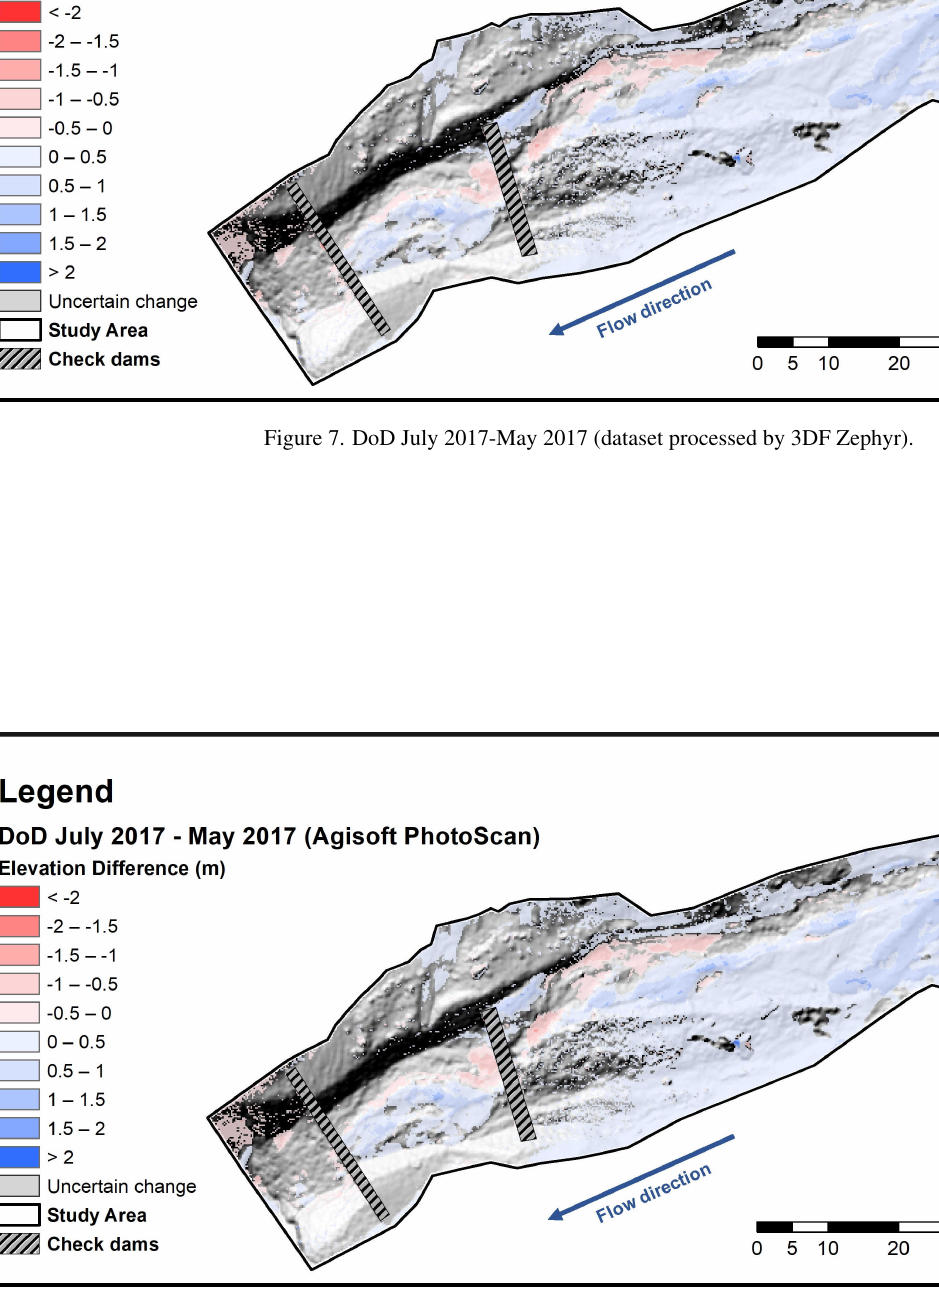
Figure 8. DoD July 2017-May 2017 (dataset processed by